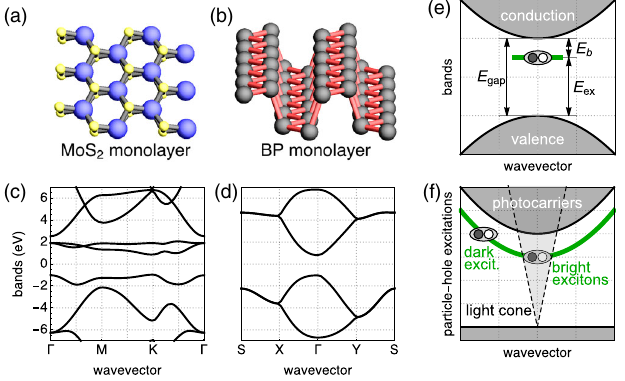
FIG. 2. Crystalline structure of MoS 2 (a) and BP (b) monolayers, with their corresponding band structures within our tight-binding approach (c,d). (e) Schematic representation of the single-particle energy bands, with an exciton state at energy E marked in green. (f) Schematic representation of the ex particle-hole excitation spectrum. Excitons within the light cone E < ℏ c j k j can decay radiatively and are thus “ bright ”